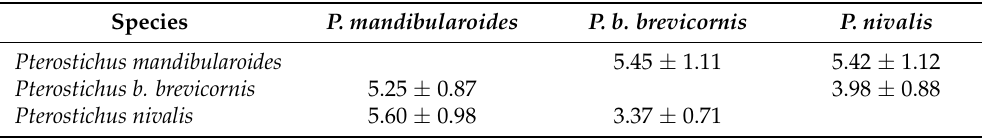
Table 2. Genetic divergences (mean uncorrected p-distances ± standard error estimations, %) between P. mandibularoides and the two other related species of the brevicornis group on the mitochondrial COI gene for the full dataset (below diagonal) and the nuclear 28S rDNA gene for Eurasian samples (above diagonal)